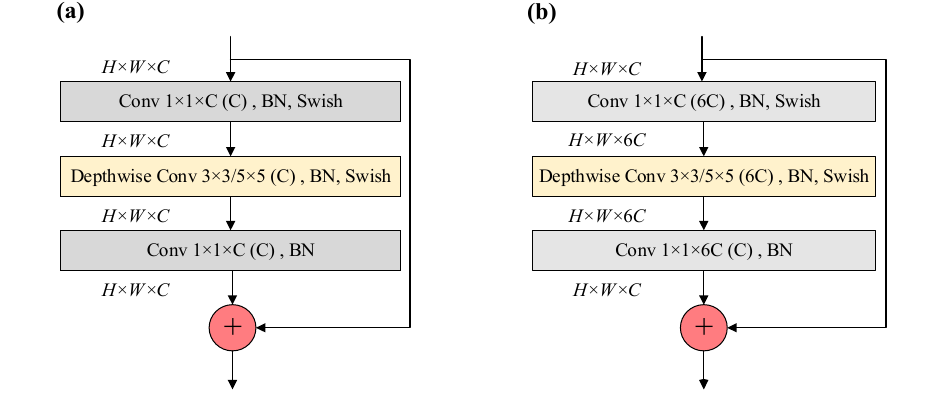
Figure 7. MBConv block: ( a ) MBConv1, ( b ) MBConv6.